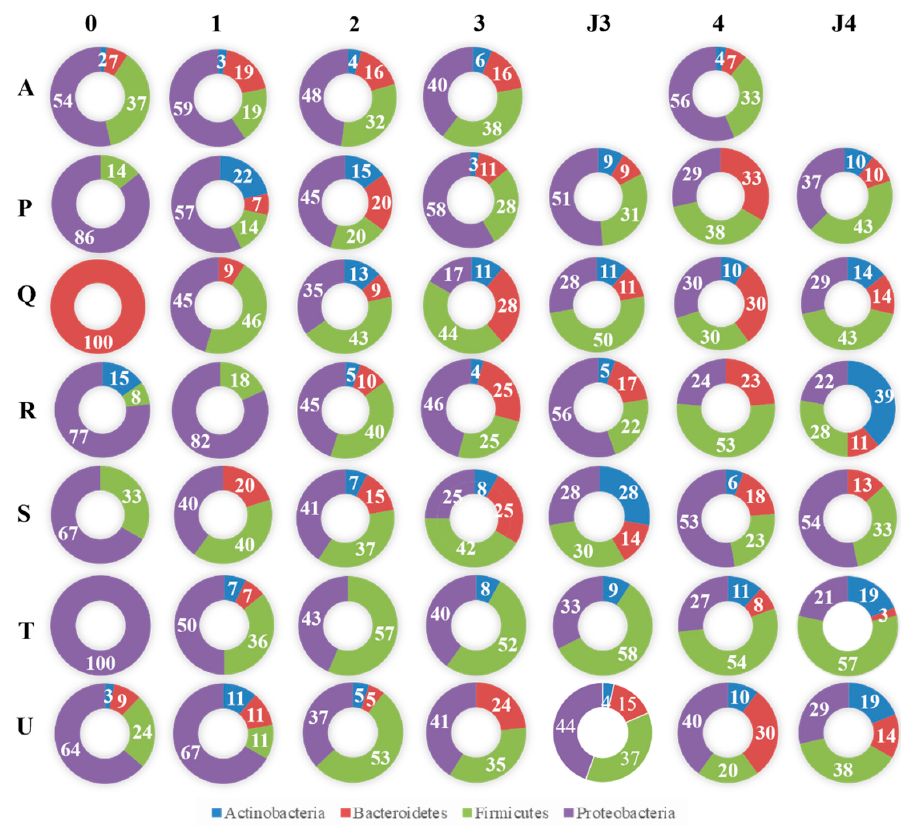
Figure 2. Culturable bacterial community compositions of all the samples at phylum level. Value represents the percentage (%). Values are rounded up to the nearest whole number.